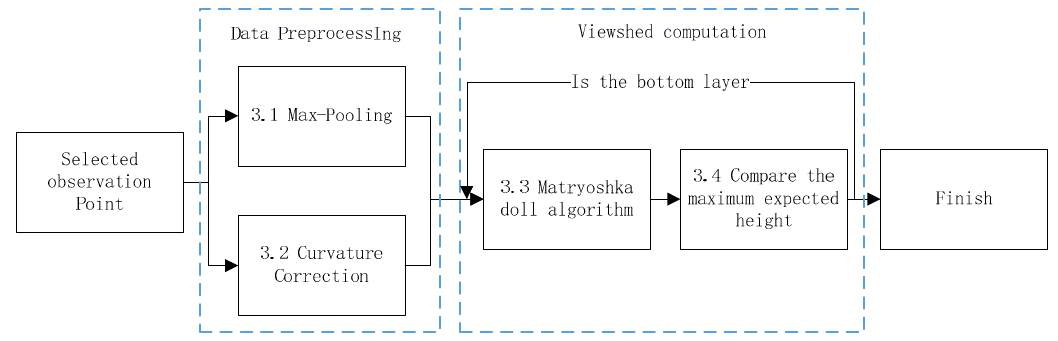
Figure 5. Flow chart of the proposed algorithm.